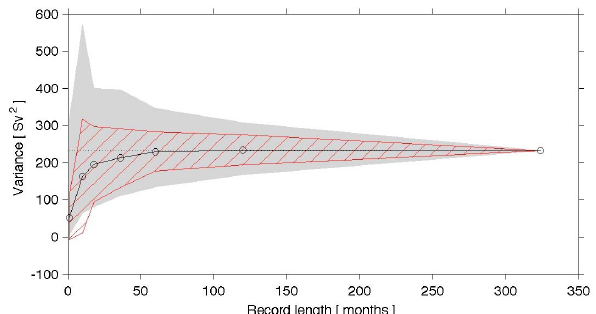
Fig. 11. Median DWBC transport variance determined via a Monte Carlo-style calculation using 1000random selections of the indi- cated record lengths of the OFES time series shown in Fig. 8. Com- Figure 11: Median DWBC transport variance determined via a Monte Carlo-style plete record variance is shown as the right-most point and the hor- calculation using 1000 random selections of the indicated record lengths of the OFES izontal dotted line. Gray region illustrates the maximum and mini- time series shown in Figure 8. Complete record variance is shown as the right-most point mum range observed for all random subsamples of a given record and the horizontal dotted line. Gray region illustrates the maximum and minimum range observed for all random subsamples of a given record length, while the red cross-hatched length, while the red cross-hatched area indicates the median values area indicates the median values plus and minus one standard deviation of the subsample plus and minus one standard deviation of the subsample variances.